Question: Sum up the contents of this chart in one sentence.
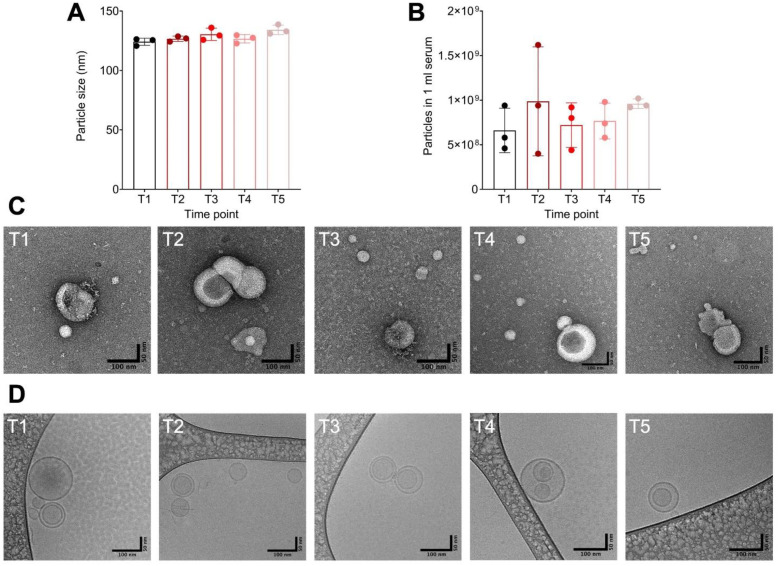
Answer: Age and sex distribution in the cohort, tumor entity and T-Stadium at time of presentation.